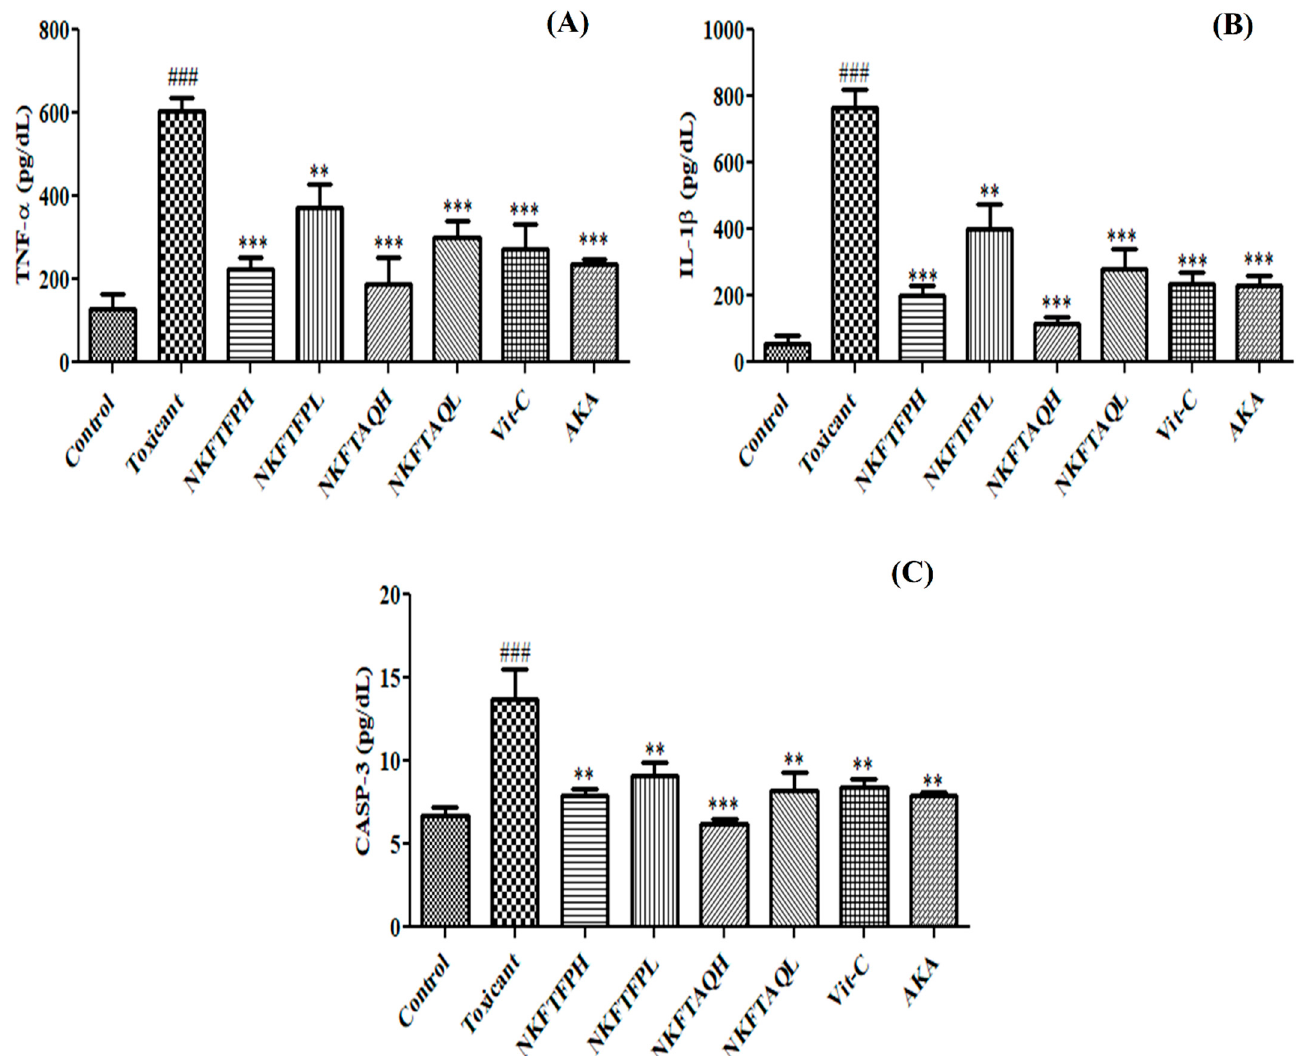
Figure 6. Effect of NKFTFP and NKFTAQE against inflammatory cytokines TNF- α ( A ), IL-1 β ( B ) and CASP-3 ( C ) induced by cisplatin in kidney tissues. The resulting data are expressed statistically as mean ± SD ( n = 6) using one-way ANOVA followed by the Tukey test to compare all pairs of the column. The comparisons are made between control to toxic (###) and toxic to drug-treated group (**/***). The statistical significance level is expressed at ** p < 0.01 (significant) and ###/*** p < 0.001 (high significant). The data represented by ‘**/***’ showed statistical difference in the activity as compared to the toxicant group.